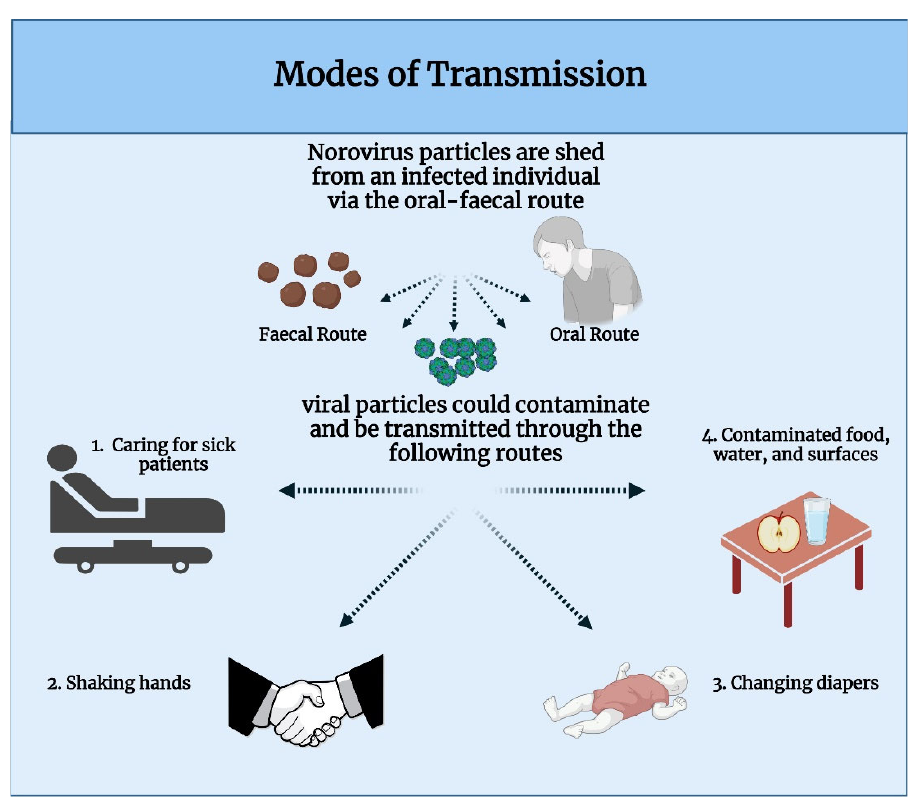
Figure 6. Transmission Modes of NoV reported by the CDC. Image made in Biorender.com ac ‐ cessed on 18 October 2022 . on 18 October